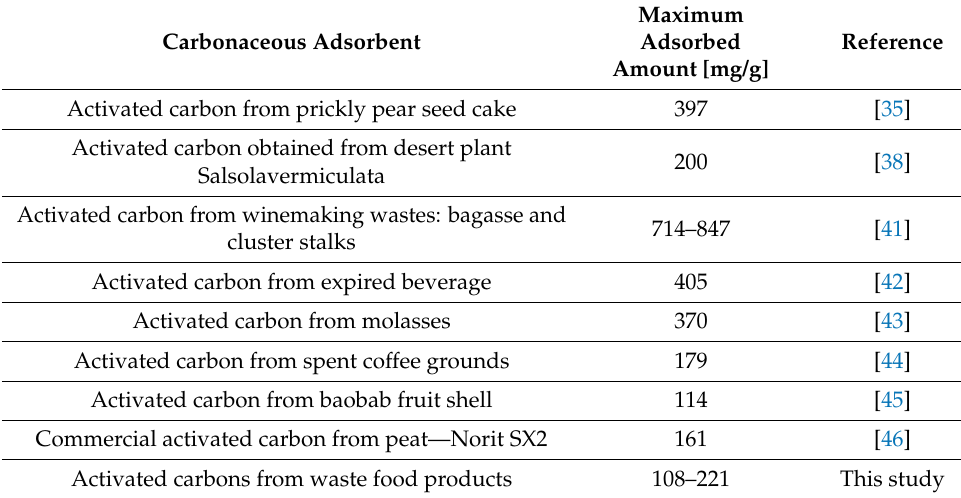
Table 6. Adsorption capacities toward methylene blue for various carbonaceous